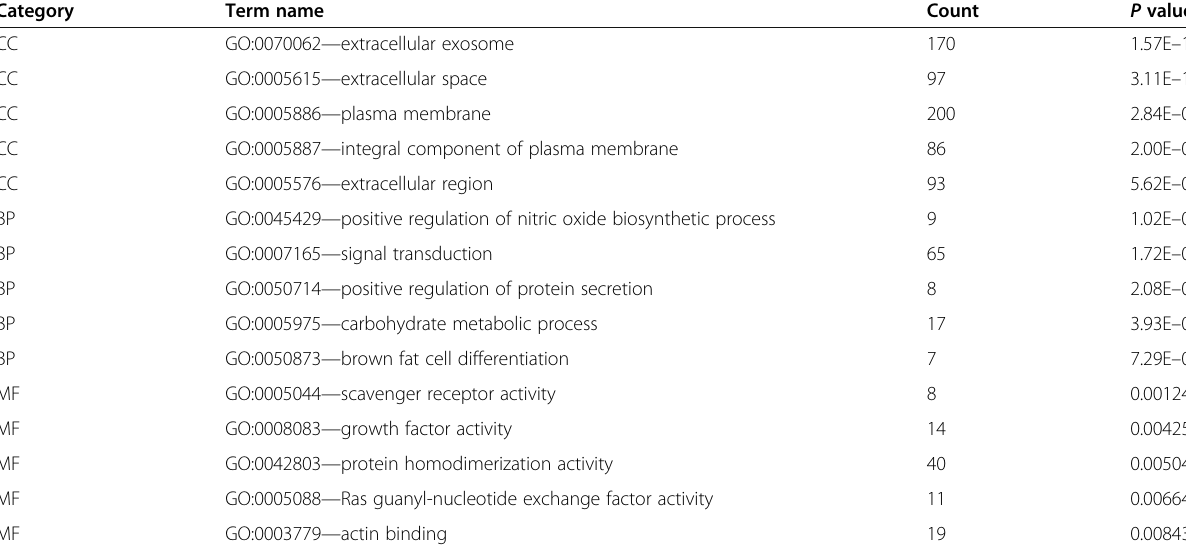
Table 2 The functional analyses of downregulated genes to identify top 15 GO terms